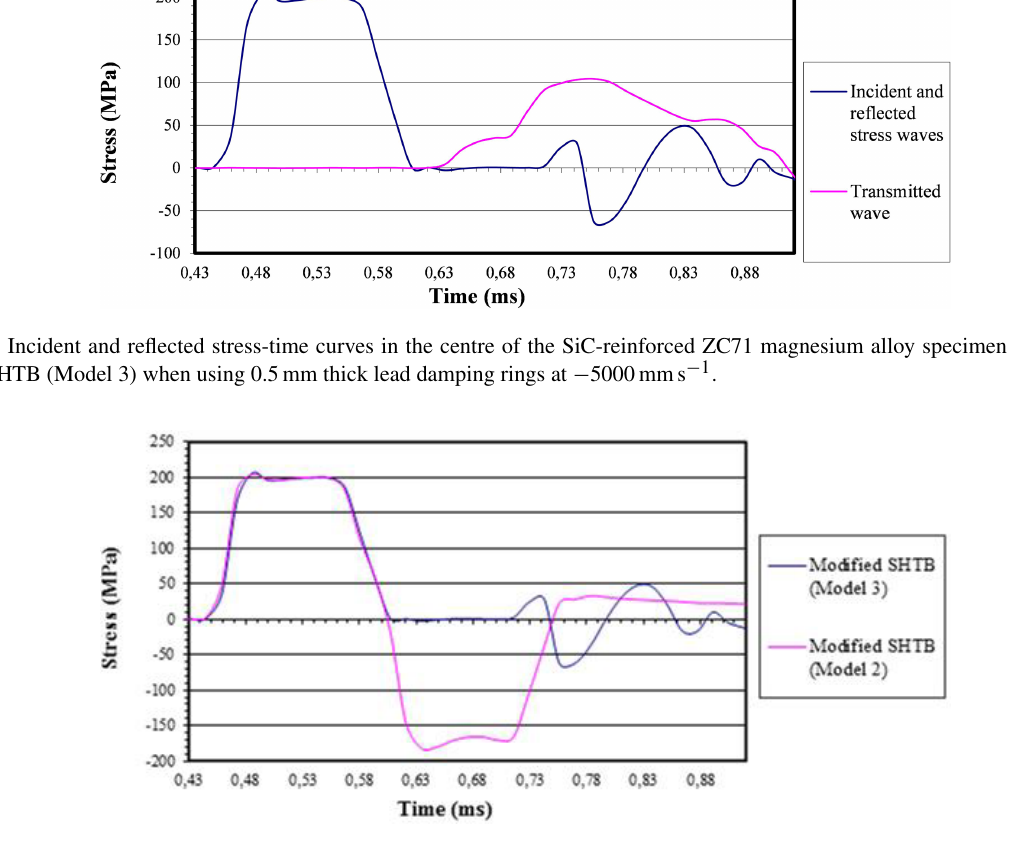
Figure 11. Incident and reflected stress-time curves in the centre of the SiC-reinforced ZC71 magnesium alloy specimen pertinent to both modified SHTB (Model 2) and modified SHTB (Model 3) when using 0.5mm thick lead damping rings at − 5000mms − 1